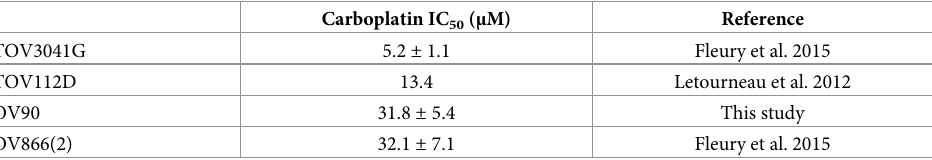
Table 1. Carboplatin sensitivity (IC 50 by clonogenic assay) of the EOC cell lines used in this